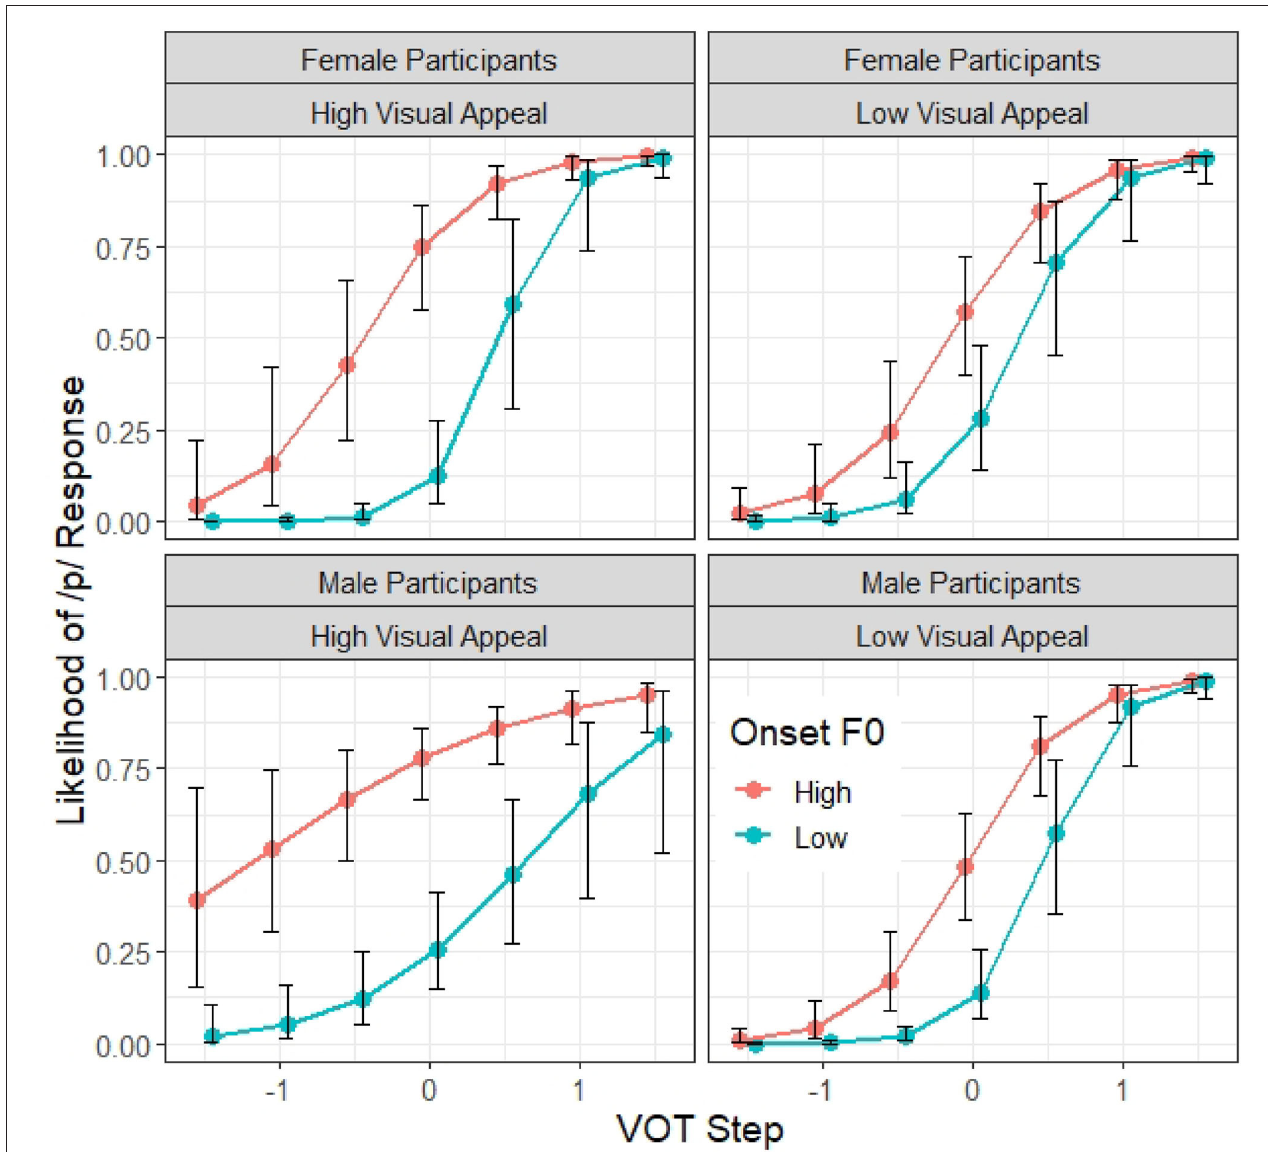
FIGURE 8 | Model 2 predictions of the probability of a /p/ response (y axis) at different steps on the VOT continuum (x axis) and F0 targets according to the talker’s visual appeal and the gender of the participant. While VISUAL APPEAL is continuous, for ease of presentation, only the patterns of talkers who were rated by the participated as having high visual appeal (i.e., 2 standard deviation above the mean) vs. those with low visual appeal (2 standard deviation below the mean) are shown in the figure. The error bars indicate 95% confidence